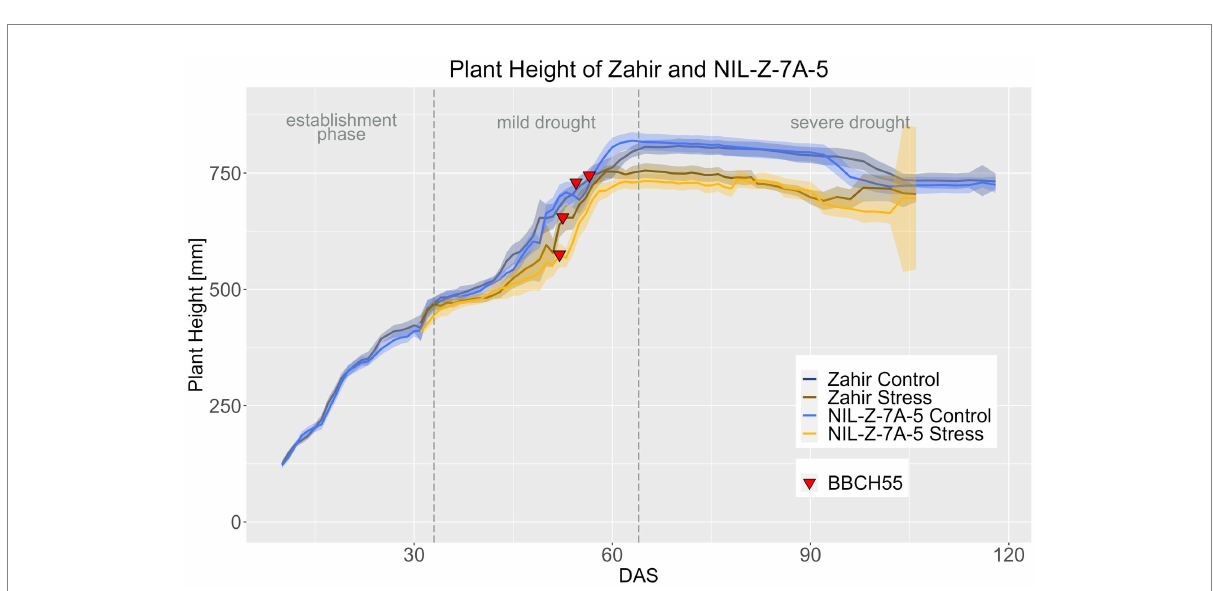
FIGURE 7 Plant height of Zahir and NIL-Z-7A-5 based on the calculated BLUEs values. DAS, days after sowing; BBCH55, heading day. The last DAS for each genotype was chosen for the DAS where the last time 60% of the plants were imaged (as mature plants were taken off subsequently). The shadows describe the confidence interval; as long as the shadows of the individual lines do not overlap, the significance level of a = 0.05 is not reached and therefore a significant difference